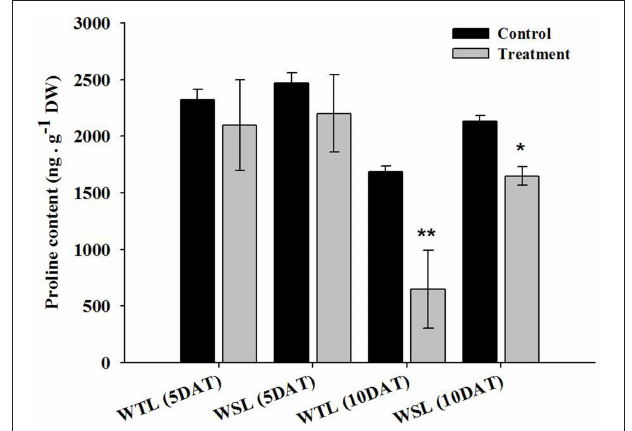
FIGURE 3 | Endogenous ABA content in the two soybean lines after waterlogging treatment. In the figures, WTL denotes the waterlogging tolerant line (PI408105A) and WSL indicates the waterlogging susceptible line (S99-2281). In the figure, star marks indicate a significant difference between control and treatment at P < 0 . 05 or P < 0 . 01 . Data is the average ± standard error ( n = 3 ).